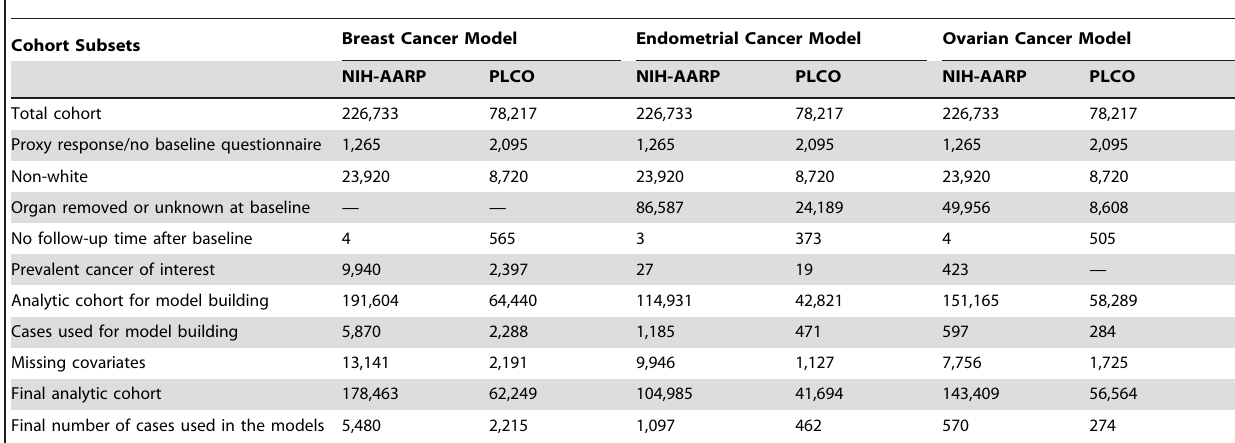
Table 1. Study populations and exclusions for model development: NIH-AARP and PLCO cohorts at baseline.